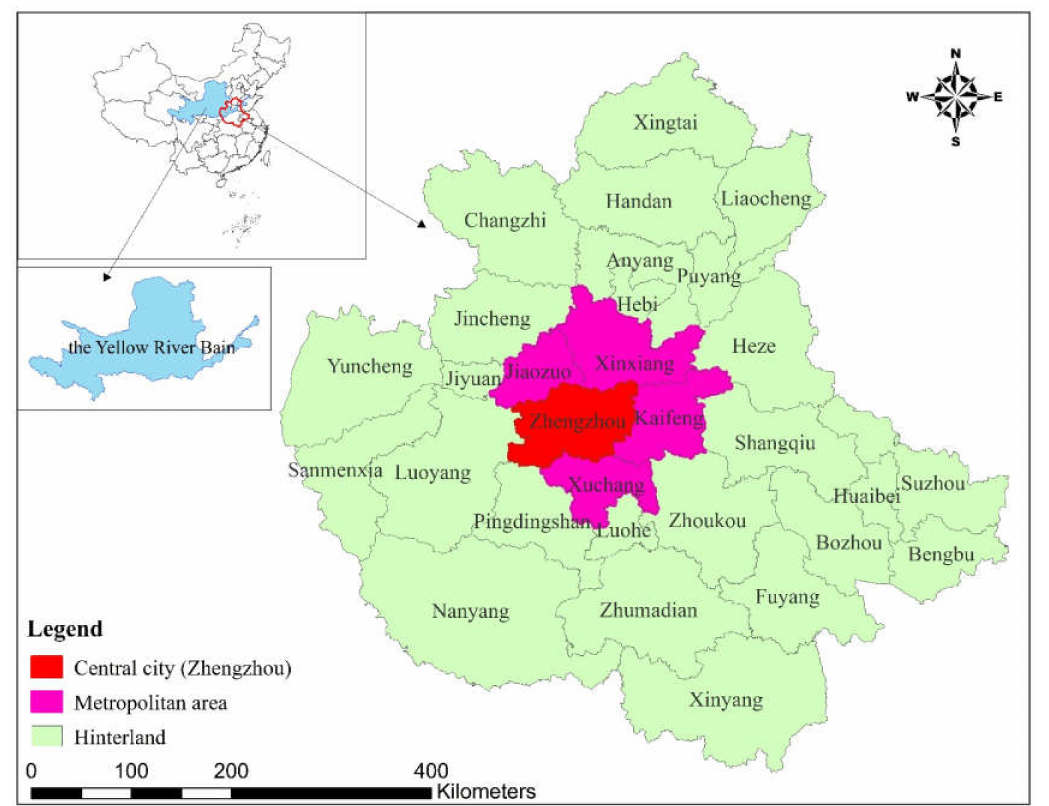
Figure 1. Scope and division of the Central Plains Urban